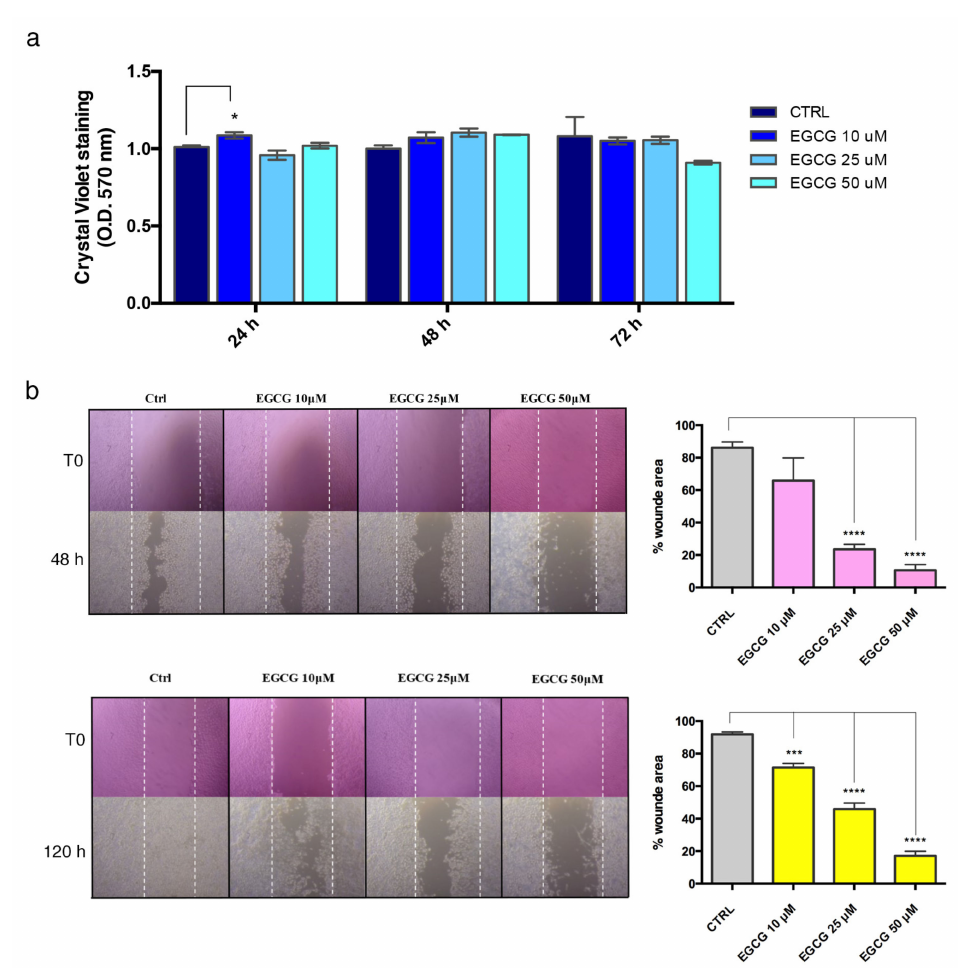
Figure 3. EGCG inhibits the wound healing process in HUVEC, without affecting cell proliferation. ( a ) The effect of EGCG on HUVEC proliferation was evaluated through CV stain after 24–48–72 h. ( b ) The effect of EGCG on HUVEC migration was analysed through the scratch assay. After scratch, HUVEC were treated with EGCG, and the wound healing was followed until 48 h and 120 h. For the analysis, HUVEC were fixed and stained with CV. Images are representative of three indepen- dent experiments (4 × magnification). Quantification of the wounded area was measured using ImageJ software and expressed as percentage. All data are expressed as mean ± SD of at least 3 independent experiments and statistical analysis was performed by unpaired Student’s t -test; *, p < 0.05; ***, p < 0.001; **** p < 0.0001. EGCG: epigallo-catechin-3-gallate; HUVEC: human umbilical vein endothelial cells; CV: crystal violet; T0: time 0, when scratch was